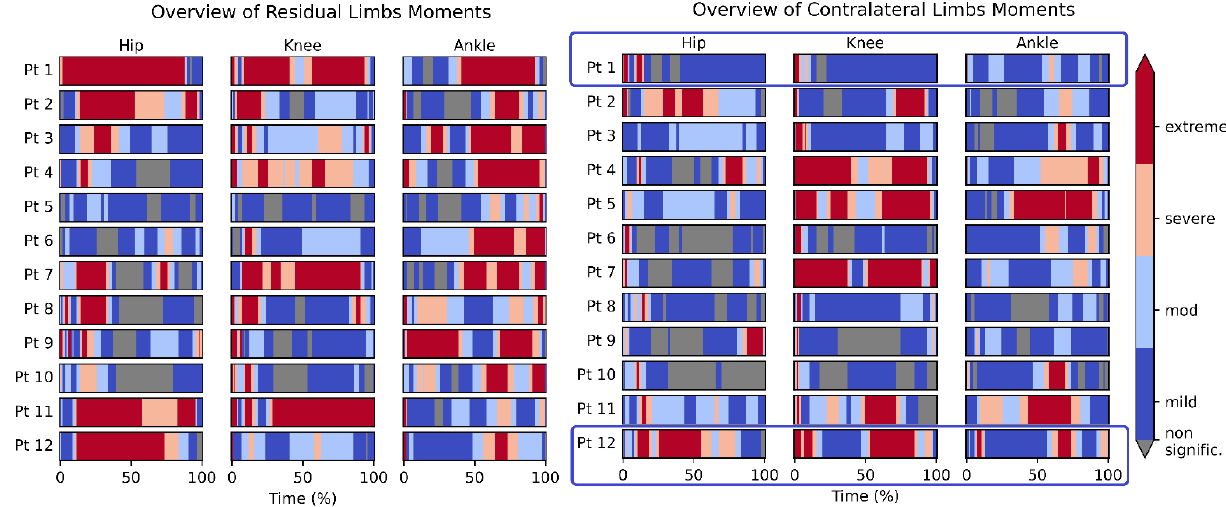
Figure 5. Overview of TTA patients’ moments. The color scheme used in this figure is identical in all figures.